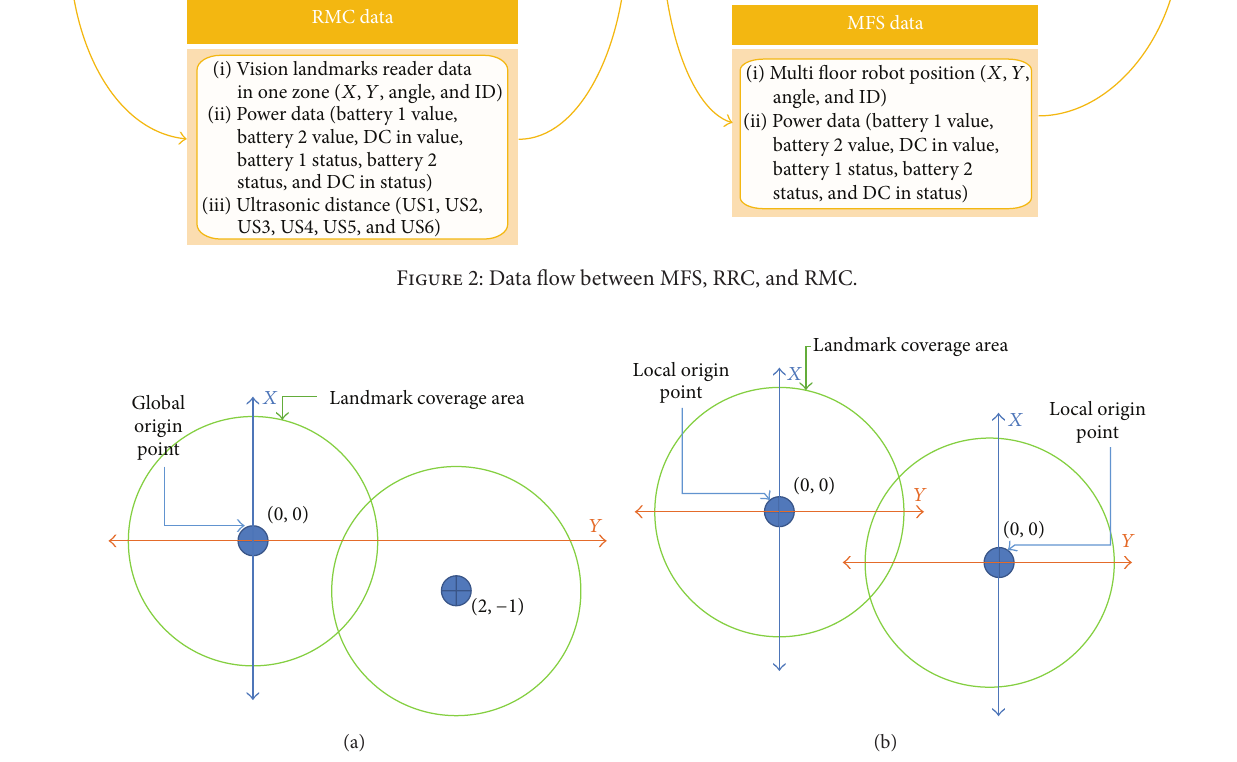
Figure 3: SGM modes. (a) Map mode. (b) Alone